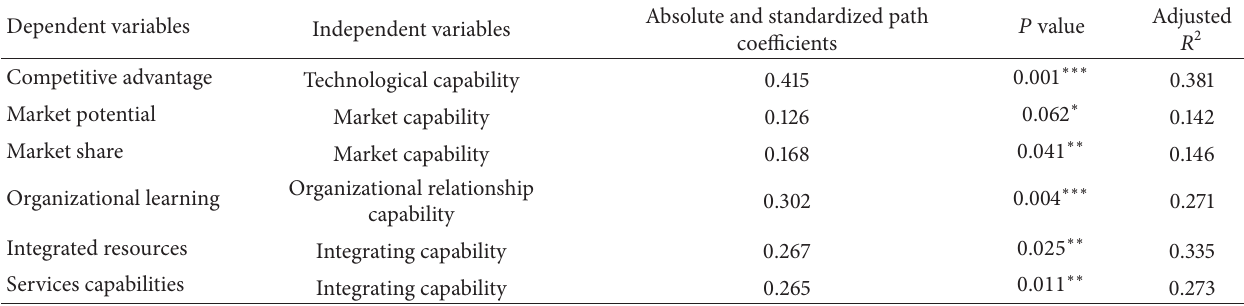
Table 6: Path analysis between 4 strategic objectives and 13 extracted CSFs. (Small technology-based firms expended by diversified products.)